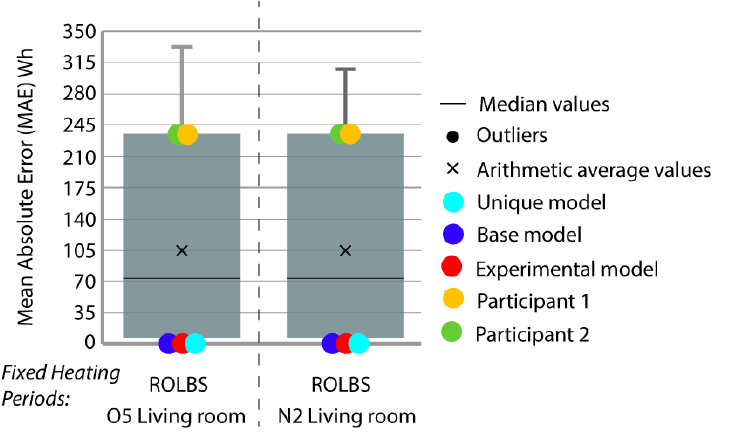
Figure 9. Energy MAE for Period 3